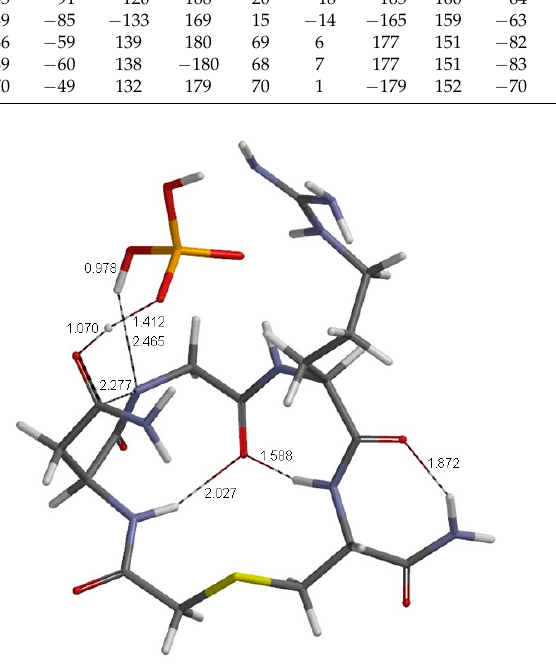
Figure 5. The geometry of TS1 (transition state of the first step) connecting RC (Figure 3) and TH1 (tetrahedral intermediate directly connected to TS1) (Figure 6). Selected interatomic distances are shown in Å. Grey: carbon; white: hydrogen; blue: nitrogen; red: oxygen; orange: phosphorus; yellow: sulfur.